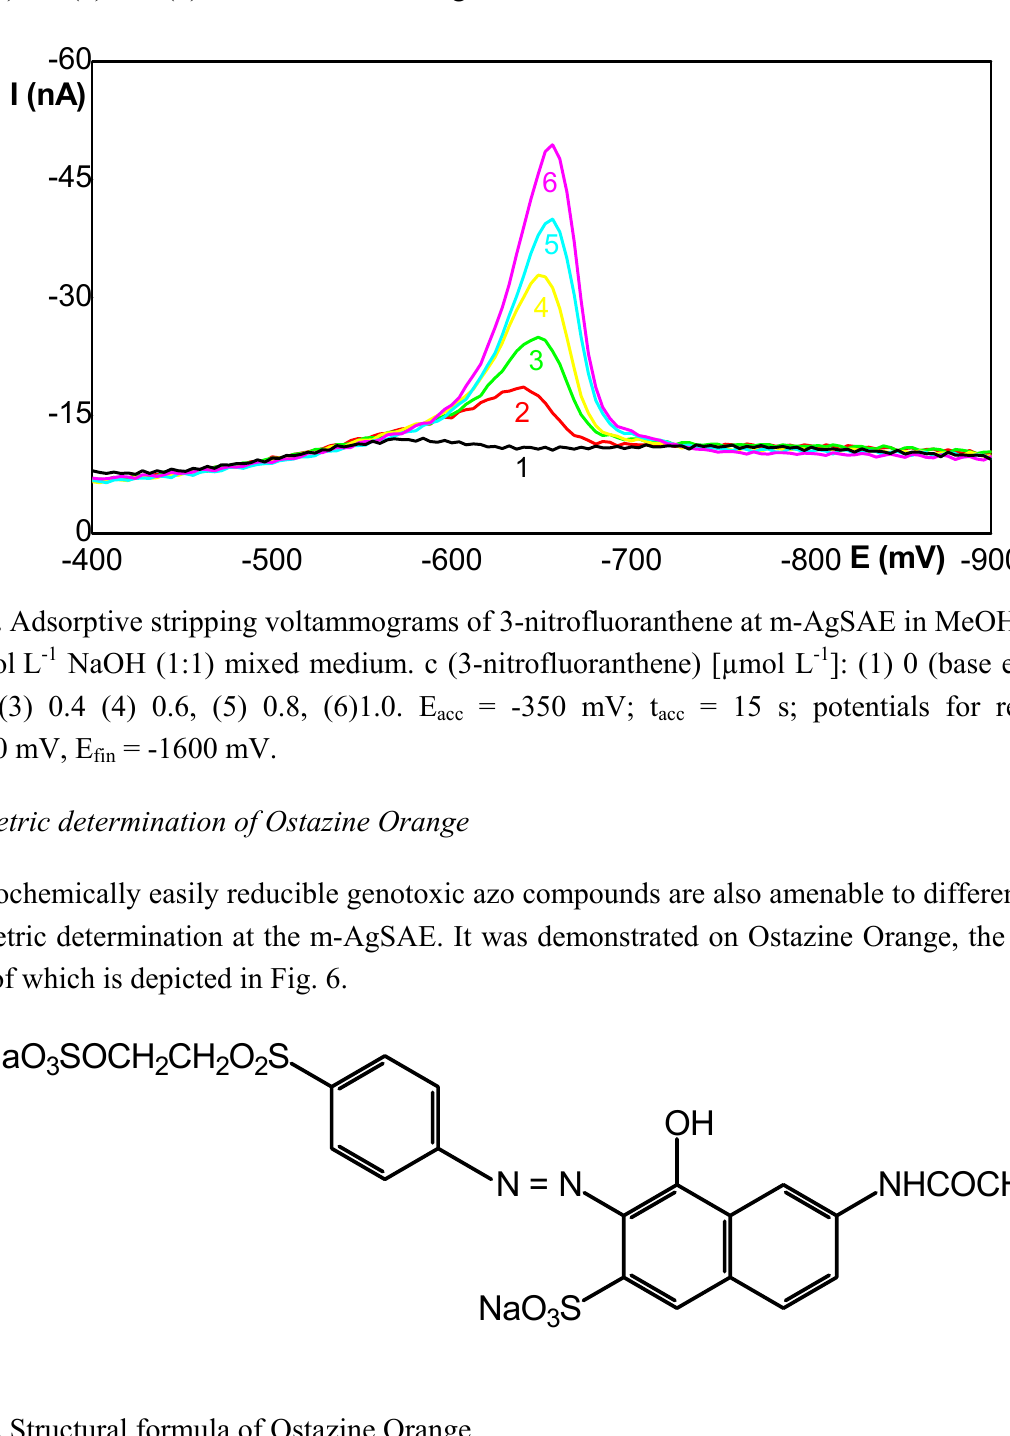
Figure 4. Differential pulse voltammograms of 3-nitrofluoranthene at m-AgSAE in MeOH - 0.01 mol L -1 NaOH (9:1) mixed medium. c (3-nitrofluoranthene) [µmol L -1 ]: (1) 0 (base electrolyte),